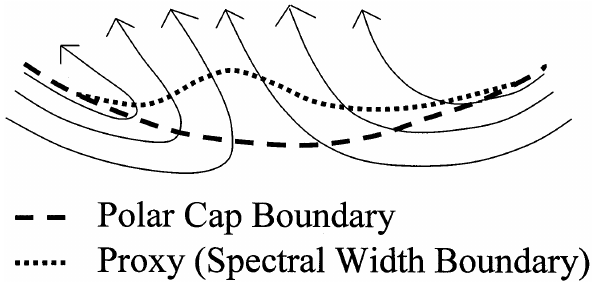
Fig. 1. A schematic representation of the relationship between the spectral width boundary and the actual polar cap boundary in the ionospheric cusp region. The spectral width boundary is offset from the polar cap boundary in regions where the convection flow has a poleward